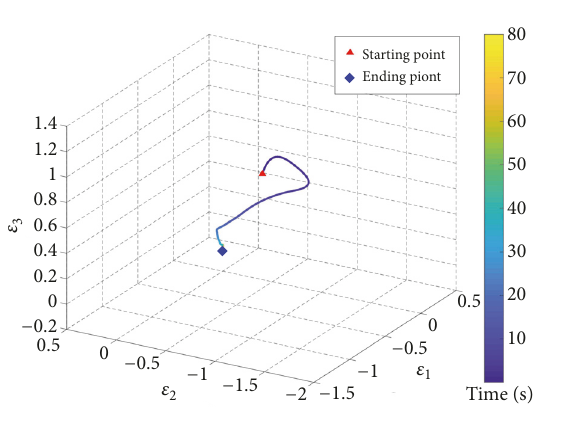
Figure 4: Three-dimensional trajectory of the transformed error 𝜀(𝑡) .